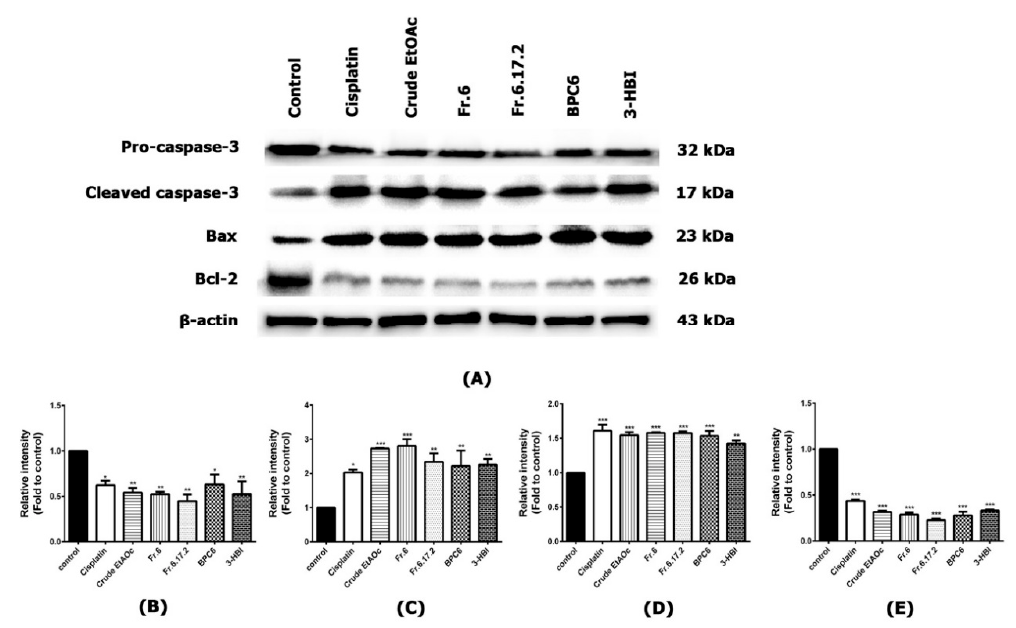
Figure 7. The inhibitory e ff ect of MO extract, fraction no. 6, sub-fraction no. 6.17.2, BPC 6 and 3-HBI on the protein expressions of SCC15 cell line. Cells were treated under di ff erent conditions for 24 h. Total proteins were extracted and determined by Western blot analysis. ( A ) Band intensity of total protein levels of pro-caspase-3, cleaved caspase-3, Bax and Bcl-2. β -actin was used as a loading control. ( B ) Relative intensity of pro-caspase-3, ( C ) cleaved caspase-3, ( D ) Bax and ( E ) Bcl-2 were quantified by scanning densitometry and normalised to control. Data are shown as mean ± SEM. * p ≤ 0.05, ** p ≤ 0.01, and *** p ≤ 0.001 compared to control. Control: untreated SCC15; Crude EtOAc: crude ethyl acetate; Fr.6: fraction no. 6; Fr.6.17.2: sub-fraction no. 6.17.2; BPC6: base peak chromatogram no. 6; 3-HBI: 3-hydroxy- β -ionone.